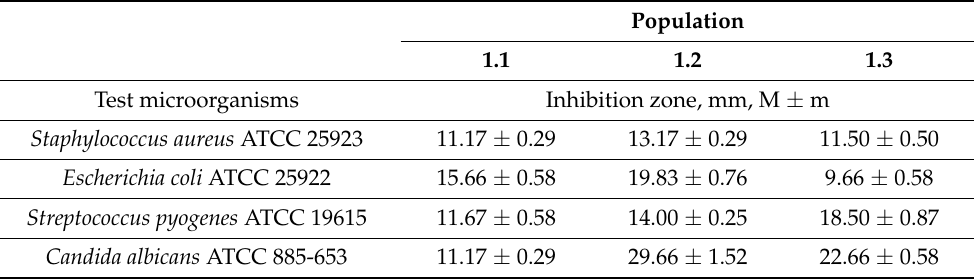
Table 3. The influence of EO from raw materials of Th. Serpyllum from different habitats on typical strains of microorganisms: inhibition zones, mm, M ±